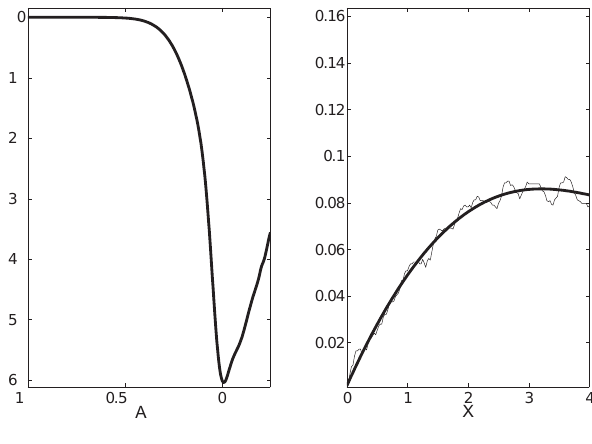
Fig. 2. PIC simulation data: Function dG/dA ≡ V ey (A) (on the left); magnetic field B z (x, 0 ) (on the right). The point A = 0 on the left picture corresponds to the magnetic field separatrices. Simula- tion data are shown by the thin line, approximation is shown by the thick